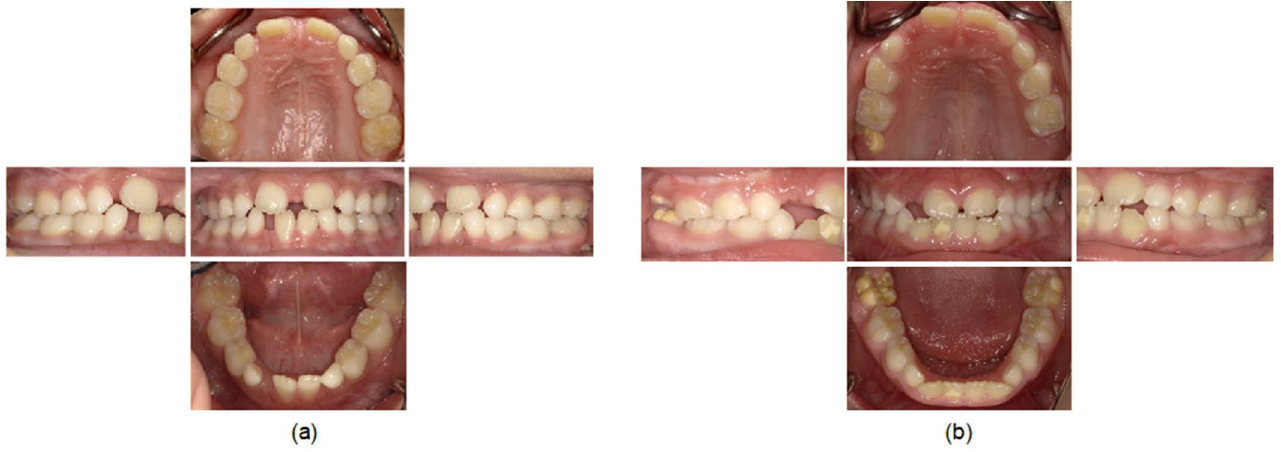
Figure 4. Intraoral photographs: ( a ) Older sister (seven years and eleven months); ( b ) Younger sister (seven years and two months).